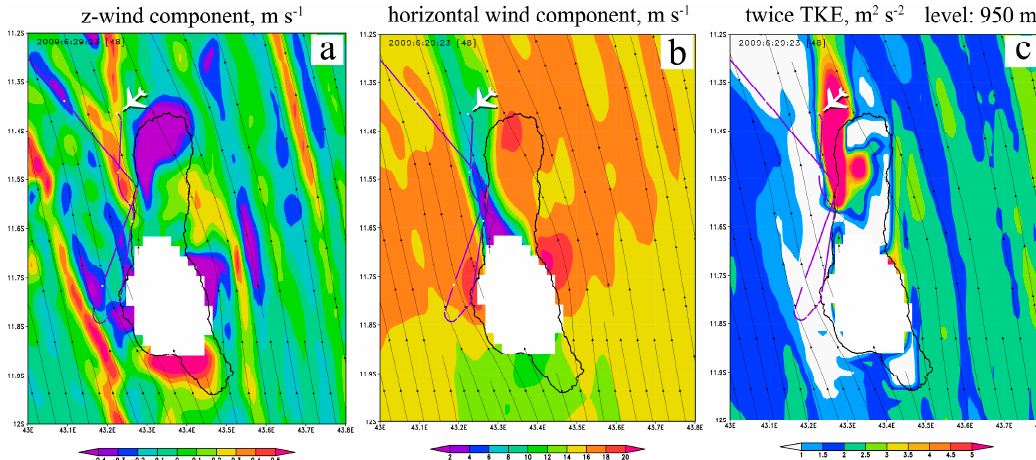
Figure 10. The Airbus A310-324 crash site, Comoros Islands, 2009. The z-wind component ( a ), the magnitude of horizontal wind speed ( b ) and the (QKE) doubled kinetic energy of turbulence ( c ). The aircraft route is indicated by a purple line.